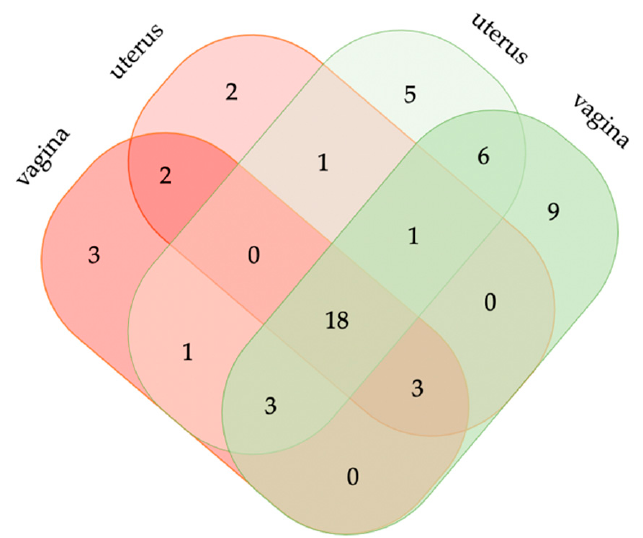
Figure 5. Venn diagram showing the number of shared genera isolated over the sampling period in the vagina and uterus of animals that remained healthy (green) and diseased (red).